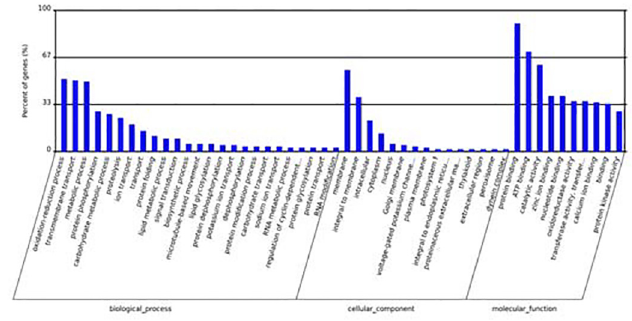
Fig 9. Partial gene ontology (GO) classification annotated for predicted target genes of 12 differentially expressed miRNAs. The figure shows partial GO enrichment of the 1813 predicted target genes in three GO ontologies: biological processes, cellular component and molecular function.